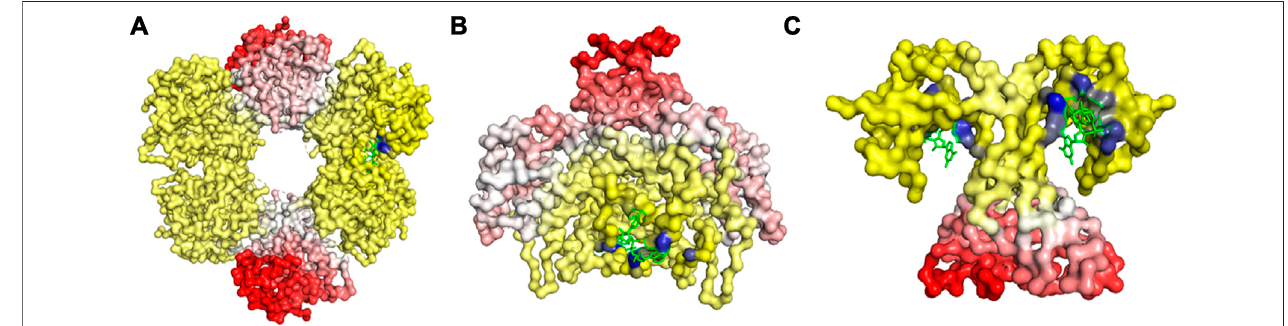
TABLE 1 | Proteins used in this study together with their corresponding PDB IDs and their ligands used to calculate residue fl uctuations in the bound state. Here ligand 46A represents N-butyl-4,6-dimethyl-N-{[2 ’ -(2H-tetrazol-5-yl) biphenyl-4-yl]methyl}pyrimidin-2-amine, NAI represents 1, 4-Dihydronicotinamide adenine dinucleotide, C2E represents 9,9 ’ - [(2R,3R,3aS,5S,7aR,9R,10R,10aS,12S,14aR)-3,5,10,12-tetrahydroxy-5,12- dioxidooctahydro-2H,7H-difuro[3,2-d:3 ′ ,2 ′ -j][1,3,7,9,2,8] tetraoxadiphosphacyclododecine-2,9-diyl]bis(2-amino-1,9-dihydro-6H- purin-6-one), PPS represents 3 ’ -Phosphate-adenosine-5 ’ -phosphate sulphate, GTP represents Guanosine-5 ’ -triphosphate, S1A represents Soraphen A, ATP represents Adenosine-5 ’ -triphosphate, AMP represents Adenosine monophosphate, MG represents magnesium ion, RFZ